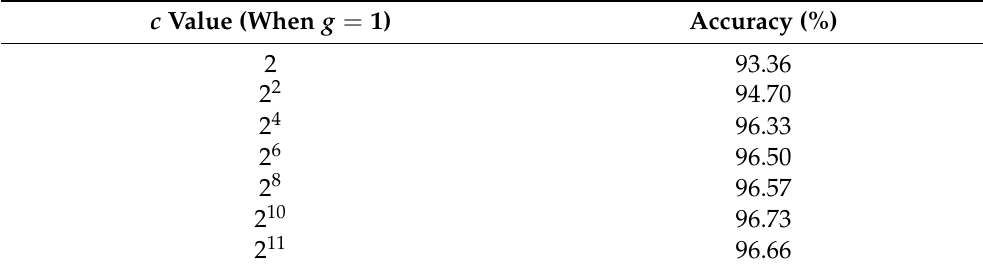
Table 3. The influence of c on accuracy (MIT-BIH arrhythmia database).